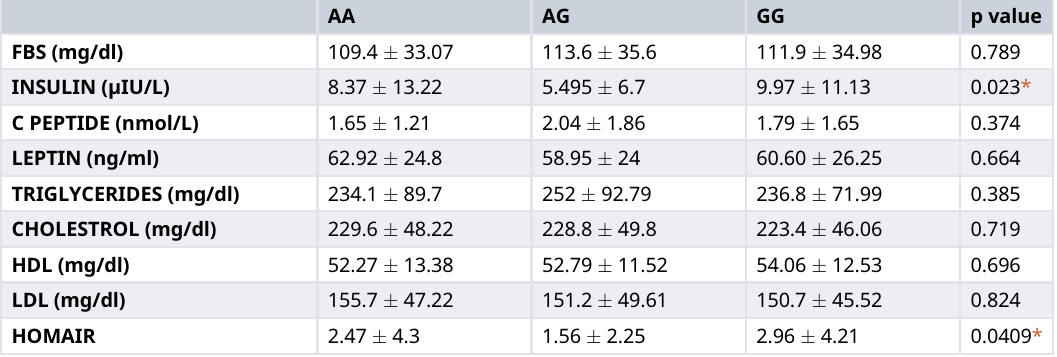
Table 7. Comparison of parameters between three alleles of leptin receptor gene.